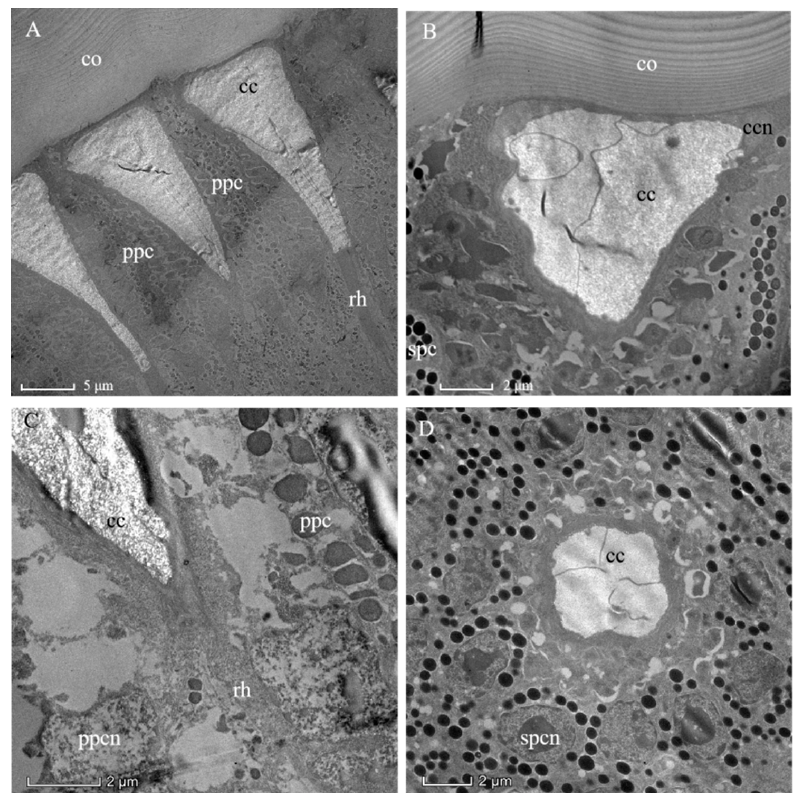
Figure 3. Transmission electron micrographs through the distal ommatidial region of the eye of a female Arge similis. ( A ) Part of the cornea and a longitudinally sectioned crystalline cone, rhabdoms, and retinular cell layer are shown. ( B ) Oblique section through cornea and crystalline cone transition zone, showing cone cell nuclei and primary, as well as secondary, pigment cells. ( C ) Longitudinal section of the cone-rhabdom contacting area, showing the proximal end of the cone enveloped by two primary pigment cells and the distal tip of the rhabdom. ( D ) Transverse section of the cone, the two primary pigment cells with severely discolored pigment grains and secondary pigment cells with spherical screening granules enveloping the central matrix of the crystalline cone. co: cornea; cc: crystalline cone; ccn: nuclei of cone cell; ppc: primary pigment cell; spc: secondary pigment cells; ppcn: nuclei of primary pigment cell; spcn: nuclei of second pigment cell; rh: rhabdom.